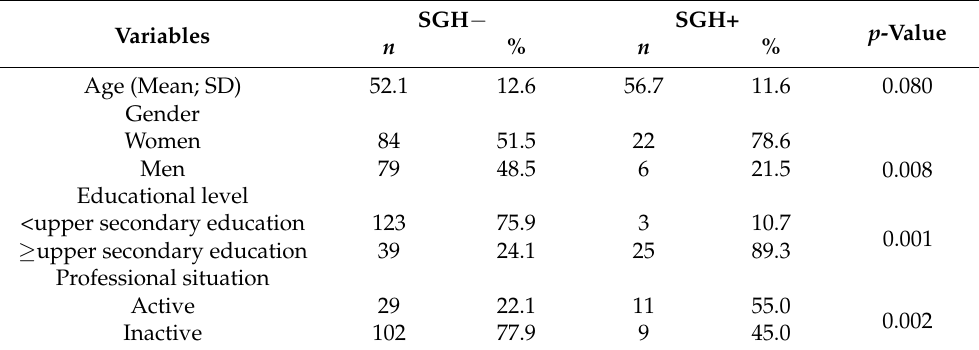
Table 2. Social characteristics of patients according to the Social Gradient of Health (SGH).